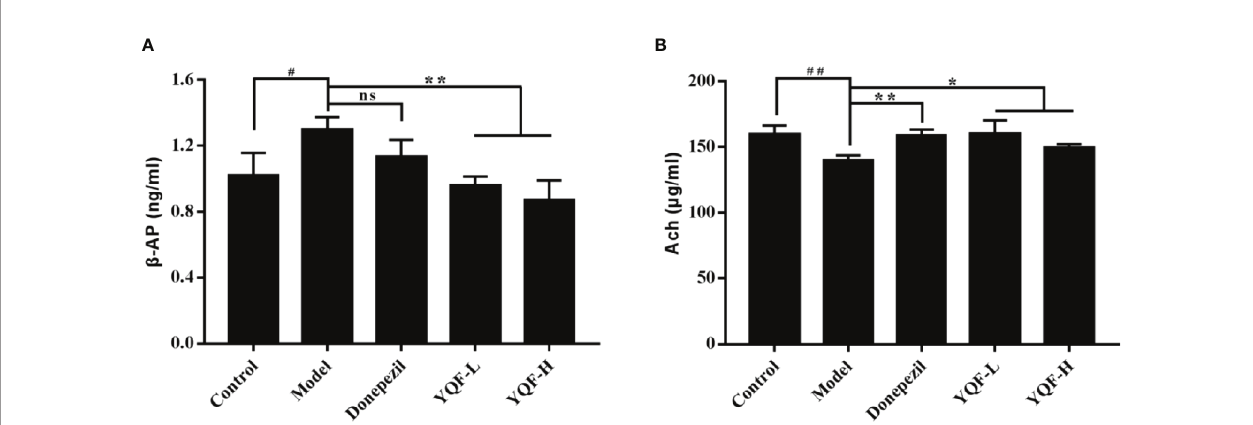
FIGURE 4 | Effects of YQF extract on b -AP and Ach levels. (A) b -AP level in aged rats. (B) Ach level in aged rats. The data are expressed as mean ± SEM, n = 10. # p < 0.05, ## p < 0.01, compared with control group; * p < 0.05, ** p < 0.01, compared with model group. ns, no signi fi cant difference.